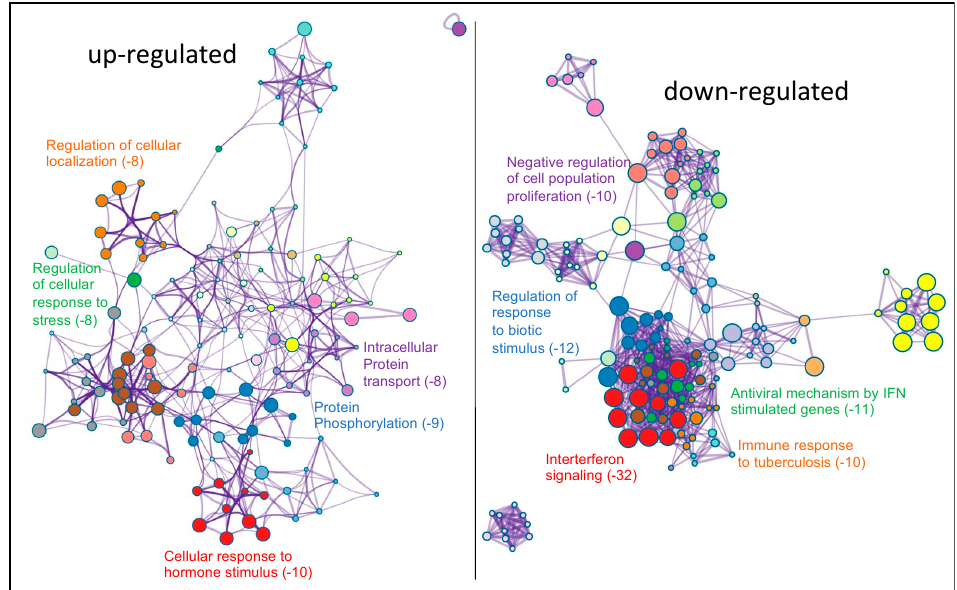
Figure 3. Functional enrichment analysis with Metascape of DEGs obtained after comparing PKC α - KD vs. PKC α -WT MCF-7 cells. Network of enriched terms colored by cluster-ID. DEGs on the left represent the up-regulated genes and on the right represent the down-regulated genes. Here, we show the five top clusters with enriched representative terms, and the numbers in brackets indicate the (Log 10 ( p -value)). Tables S2a and b show the genes included in each cluster.